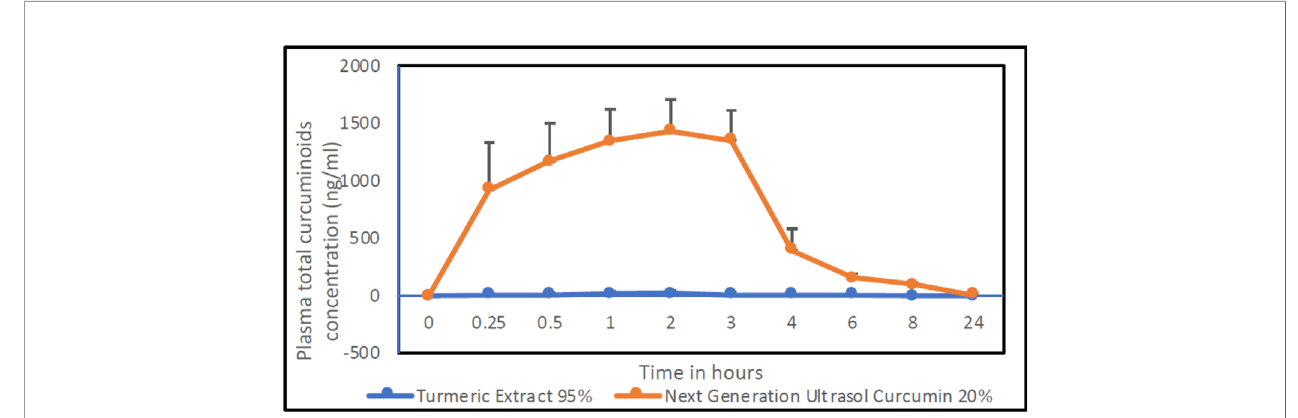
FIGURE 1 | Plasma concentration of total curcuminoids vs. time pro fi les after oral administration of NGUC and 95% turmeric after dosing aqueous suspension of equivalent amount of total curcuminoids (dose 200 mg/kg body weight). The data are presented as means ± SD